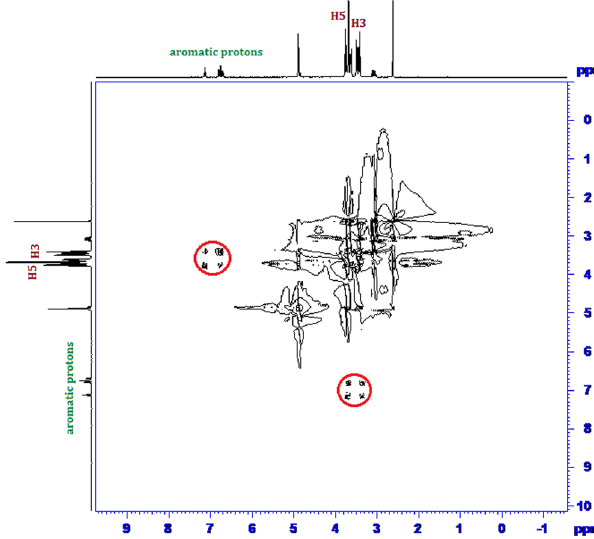
Figure 11. 2D ROESY NMR spectra of the solid (PEH + β -CD)